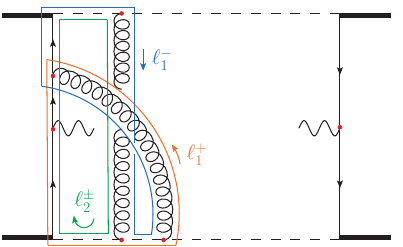
and (cid:96) for 1 2